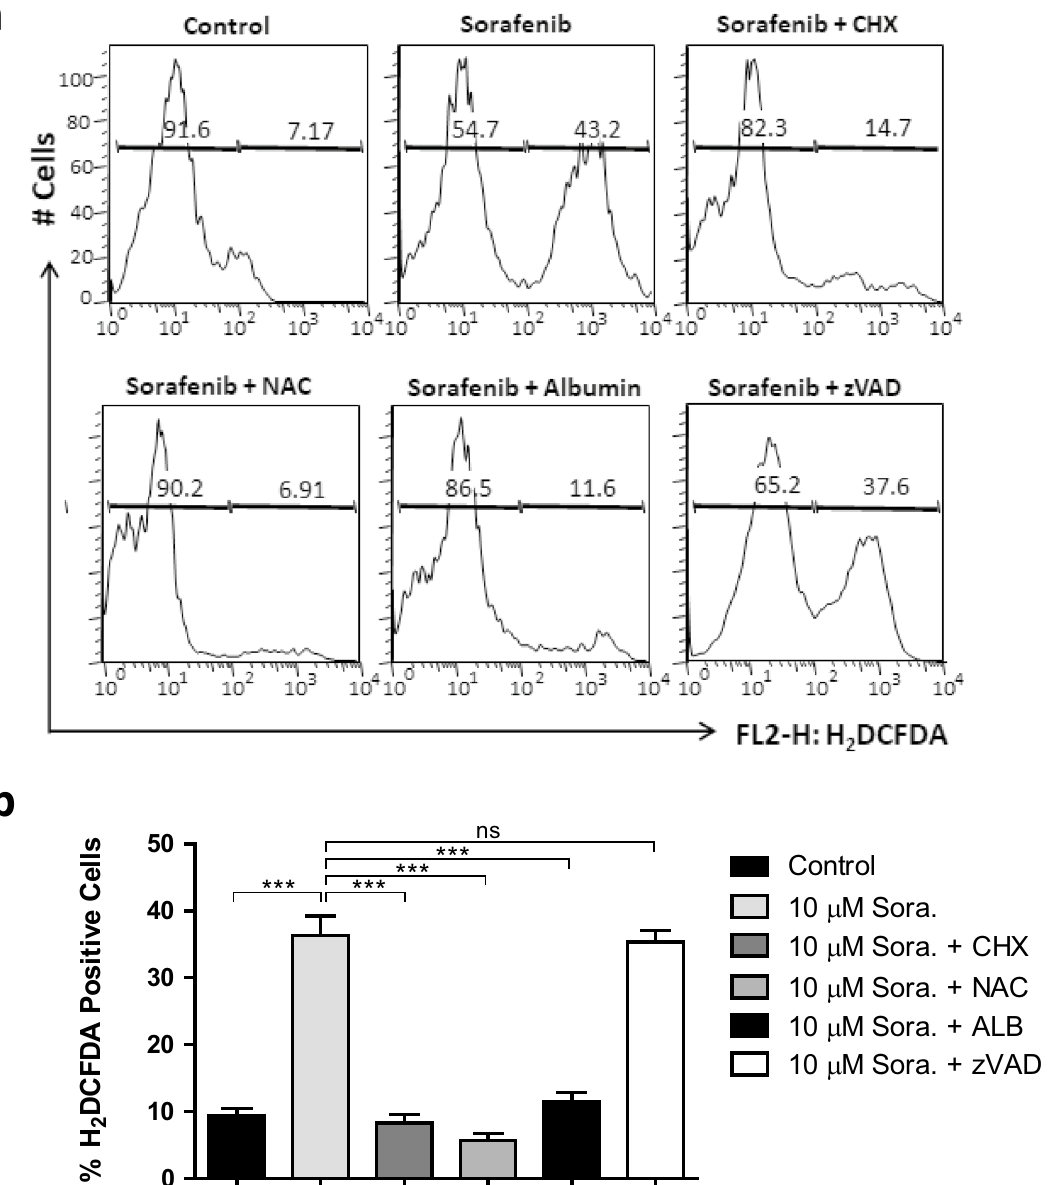
Figure 5. ROS participate in sorafenib induced stress. ( a ) Sorafenib induced cellular reactive oxygen species (ROS) were measured by positive population of the fluorogenic dye, 2 ′ ,7 ′ -dichlorodihydrofluorescein diacetate (H 2 DCFDA) in LX2 cells with or without pre-treatment of different inhibitors and anti-oxidants N -acetylcysteine (NAC), human serum albumin (ALB), protein synthesis inhibitor cycloheximide (CHX), and pan-caspase inhibitor vZAD. ( b ) The quantification of percentage (%) H 2 DCFDA positive LX2 cells with sorafenib exposure after pre-treatment with above mentioned inhibitors. Statistical analysis performed with grouped data to show the significant difference among relative H 2 DCFDA positive cells. Data represent mean ± s.d. from three independent experiments (ns > 0.05, ***P < 0.001 One-way analysis of